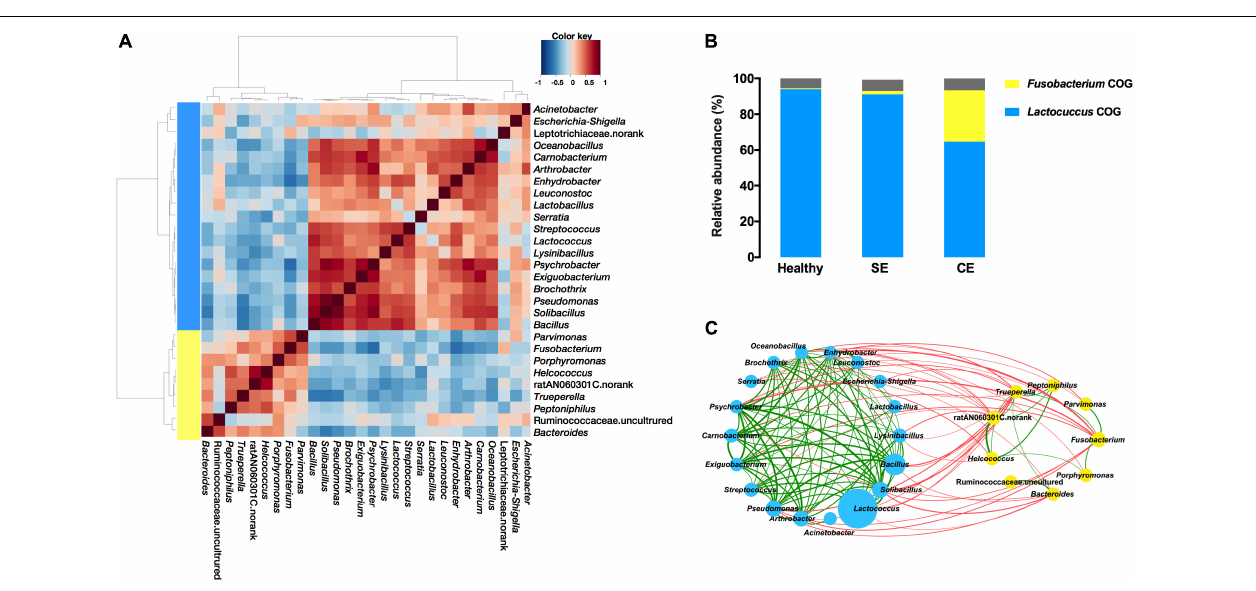
endometritis at 21 days postpartum was not associated